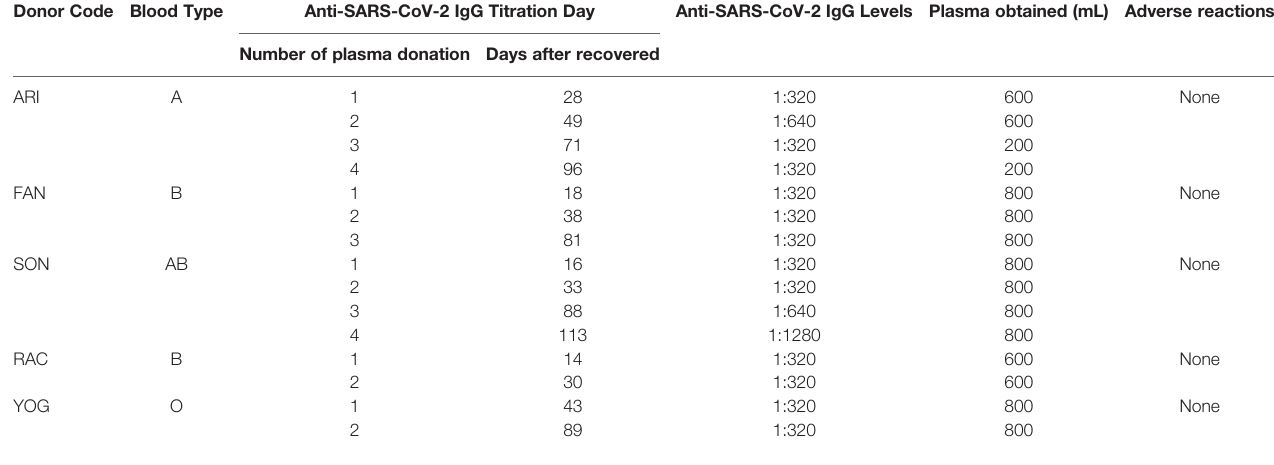
TABLE 3 | Comparison of titration days and anti-SARS-CoV-2 IgG levels during preparation for convalescent plasma donation. Donor Code Blood Type